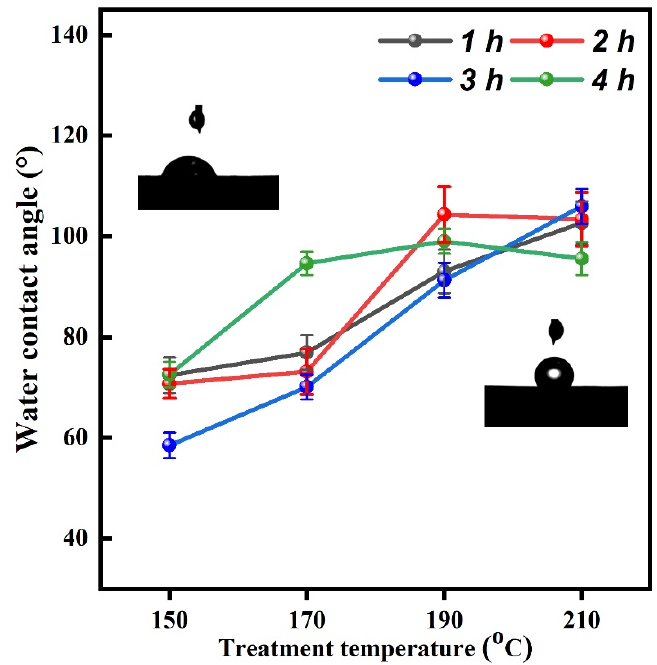
Figure 9. Contact angle of different bamboo samples